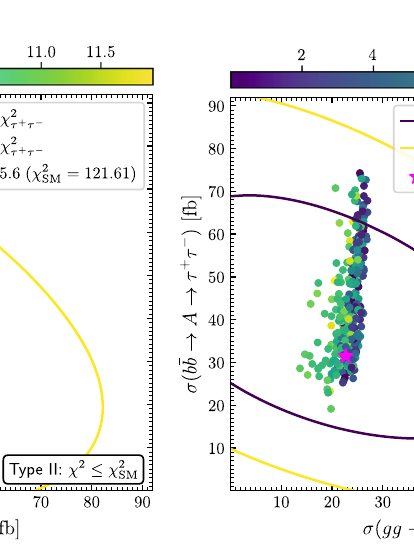
The dark blue and the yellow lines indicate the 1 σ and 2 σ ellipse of χ 2 τ + τ − , respectively. The best-fit point is indicated with a magenta (right). 96